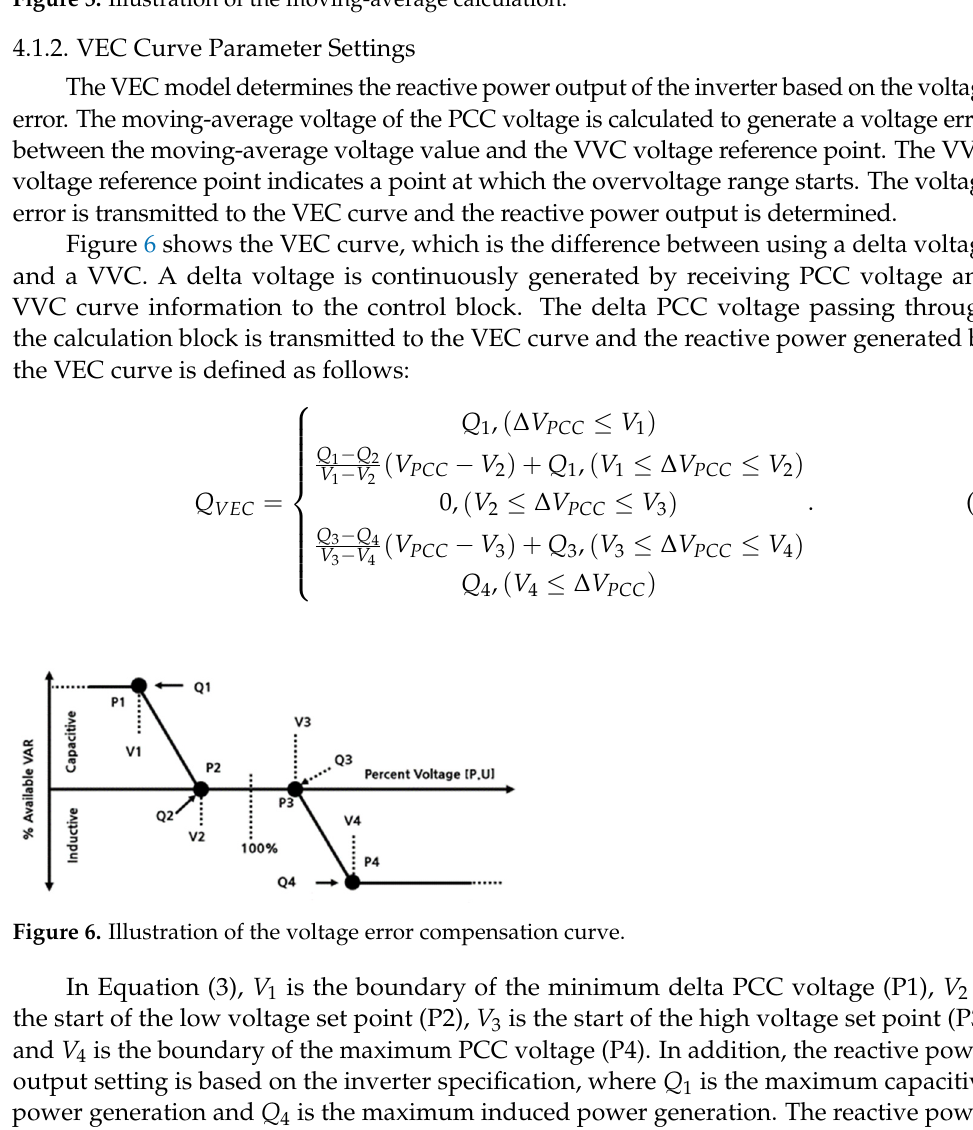
Table 1. VEC curve parameter settings.